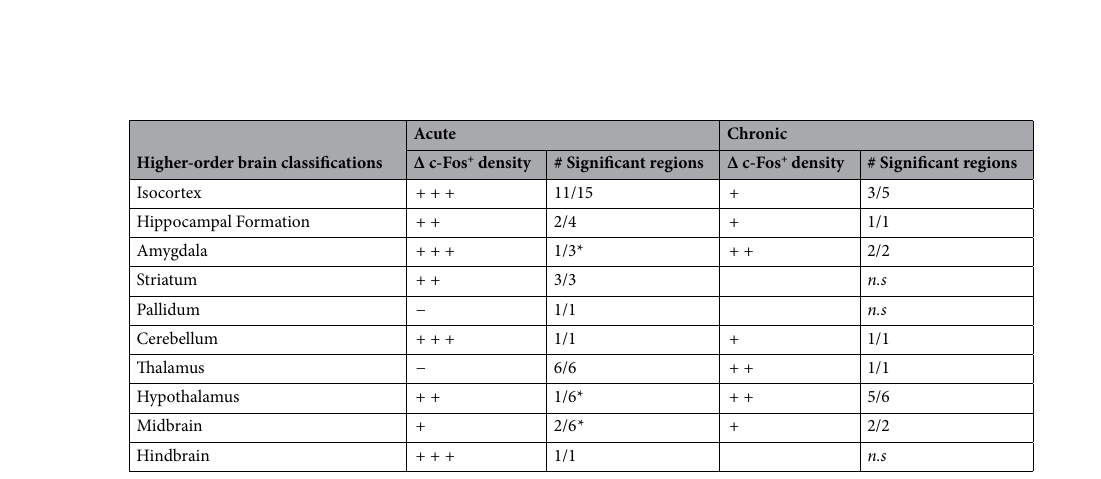
Table 1. General direction of change in c-Fos expression following Acute or Chronic LI-rTMS, organised across higher order brain classifications. % Δ in c-Fos density compared to group sham per region, averaged across higher order brain classification: − = − 200–0%; + = 0–200%; + + = 201–500%; + + + > 500%. # significant regions = # significantly modulated regions changing in the labelled direction/total # of significantly modulated regions within the higher order classification; * = Higher order classifications consisting of predominantly significantly down-regulated regions, with a minority of highly upregulated regions. Overall, the degree of upregulation was greater than downregulation, but the regional downregulation was more numerous is several higher-order brain classifications. n.s = no significant regions.